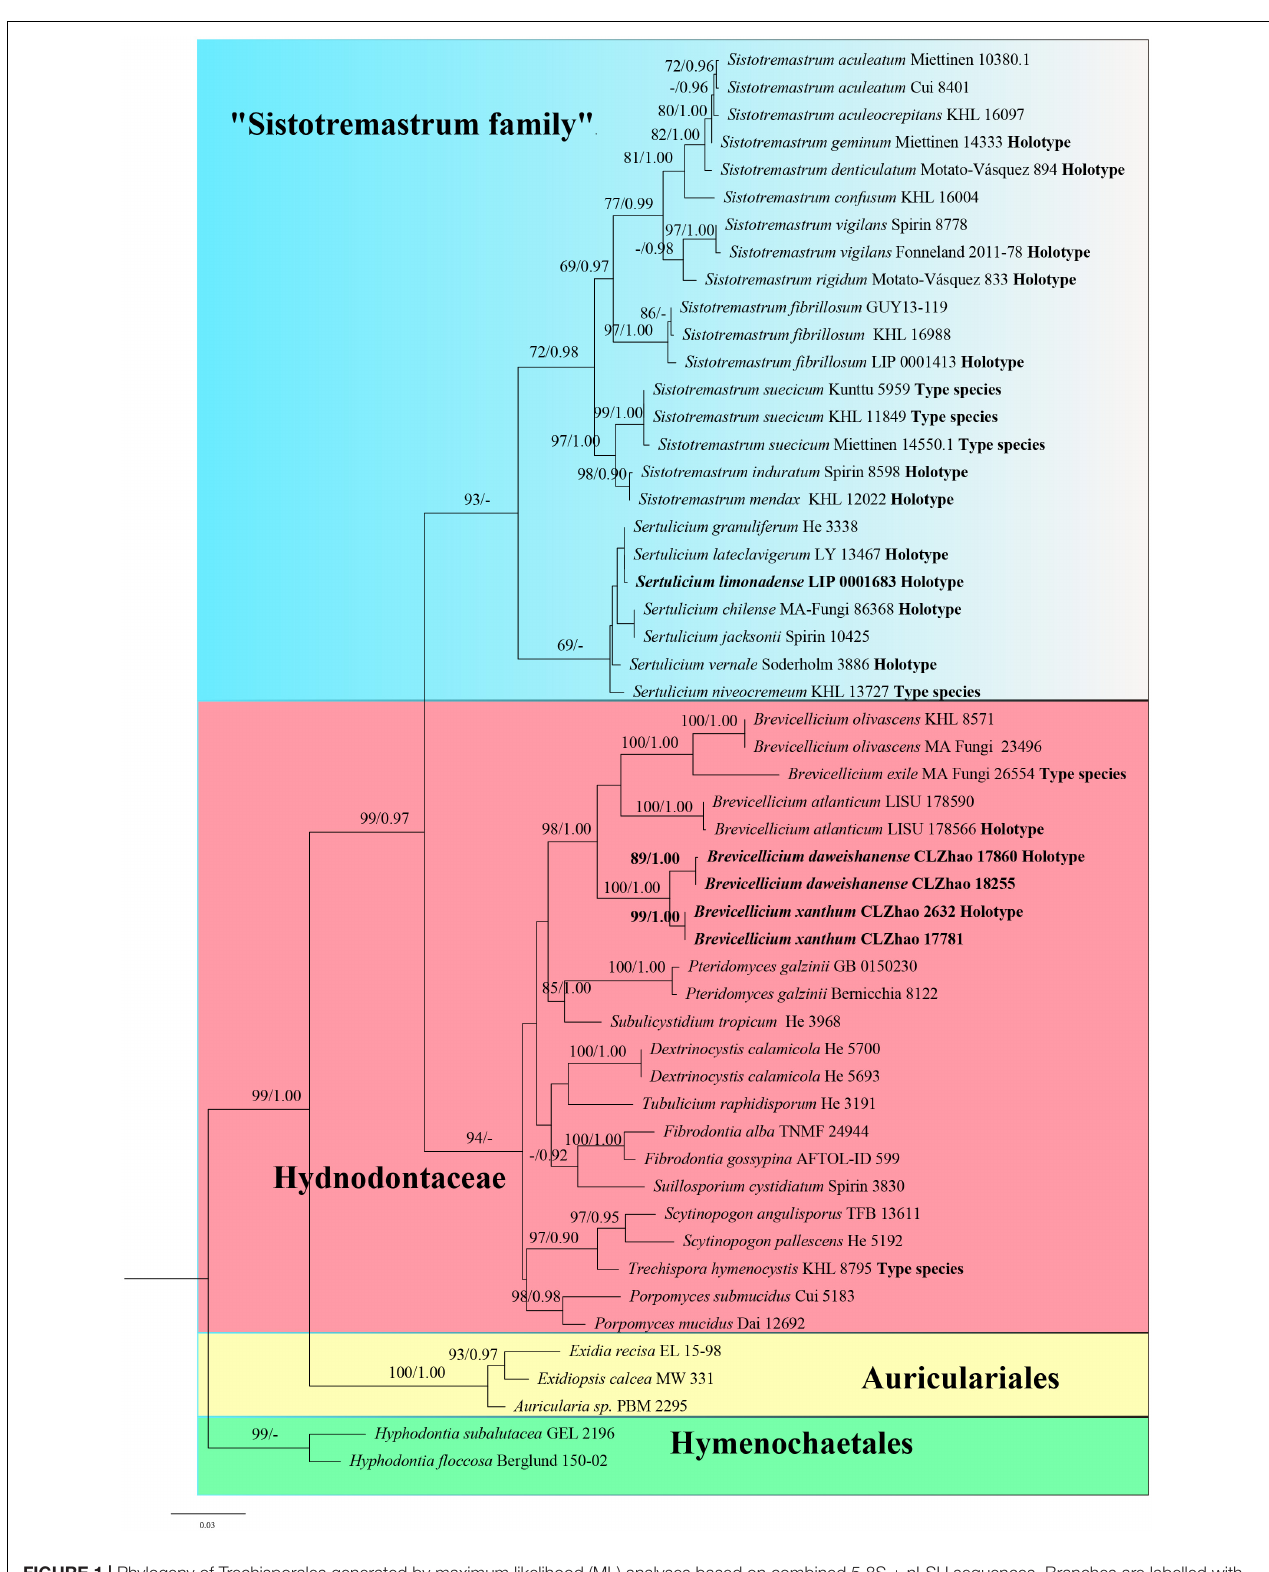
FIGURE 1 | Phylogeny of Trechisporales generated by maximum likelihood (ML) analyses based on combined 5.8S + nLSU sequences. Branches are labelled with ML bootstrap (BT) > 65%, and Bayesian posterior probabilities (BPP) > 0.90, respectively. New combinations, the sequence origin from holotype and the type status of the species in the genus are indicated in